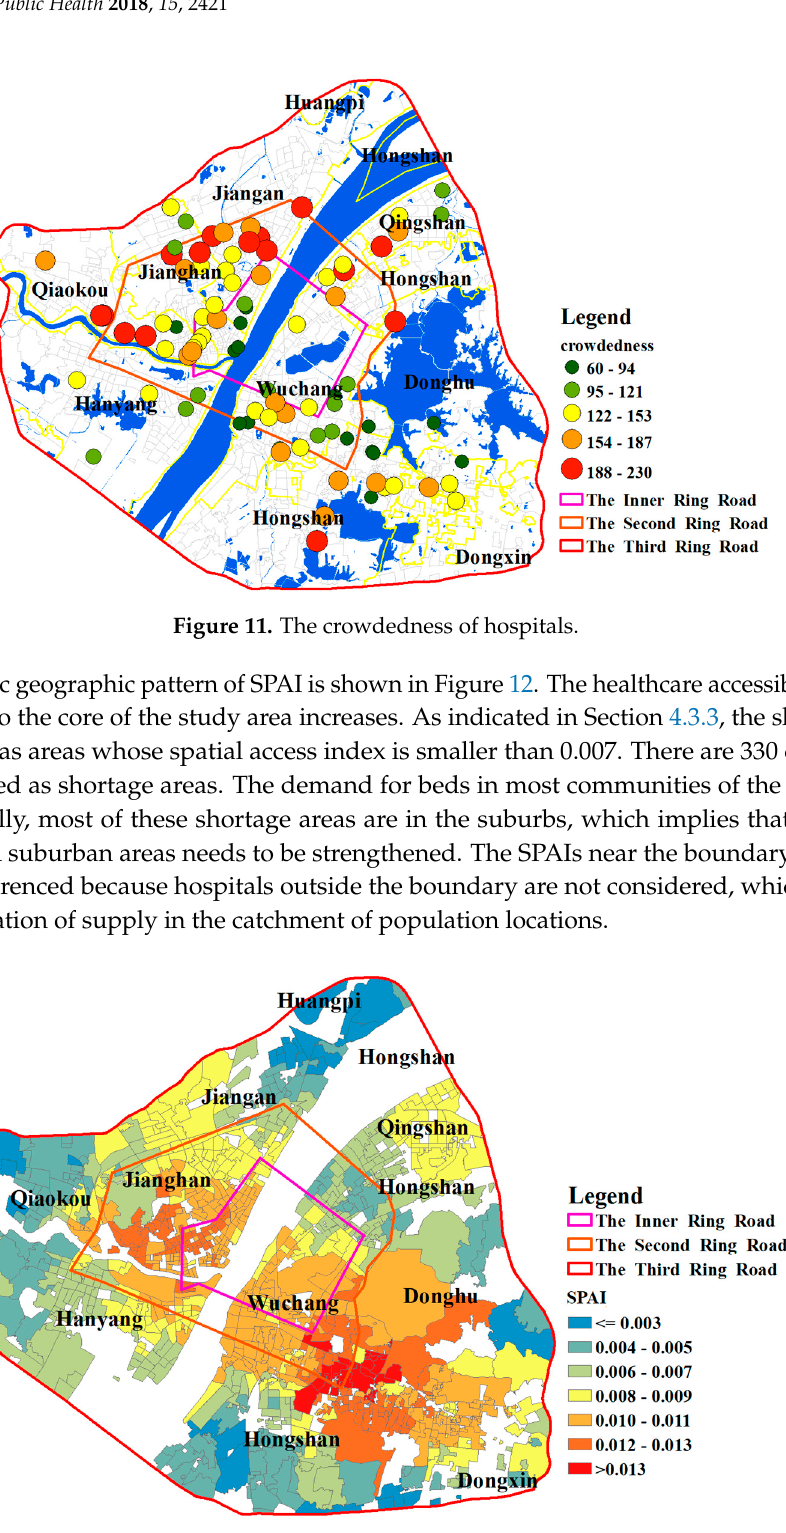
Figure 12. The geographic pattern of SPAI.